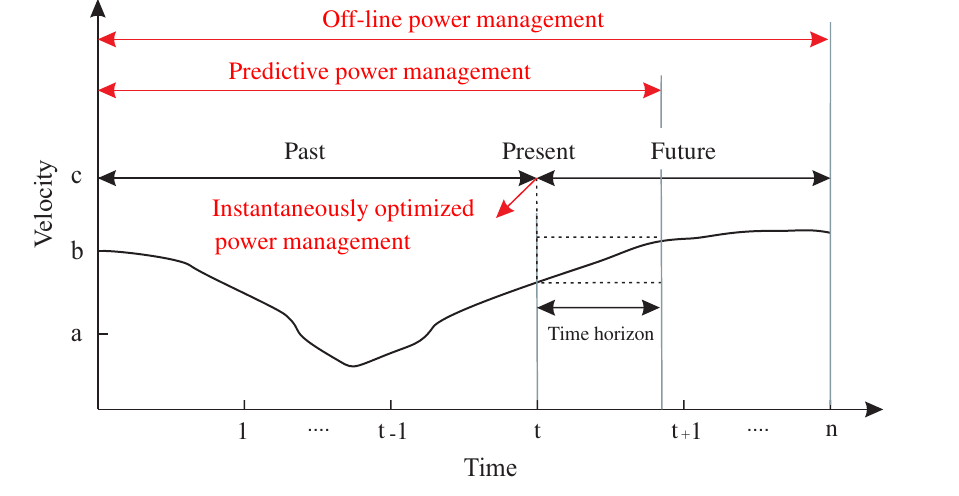
Figure 1. Optimization time domain for off-line, on-line, and real-time power managements.